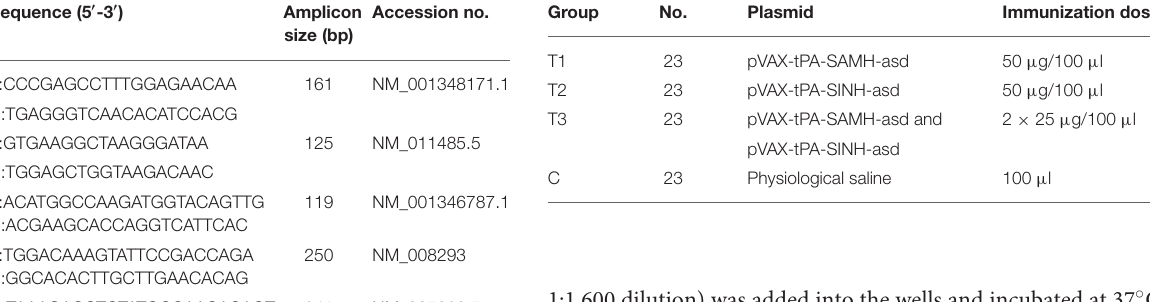
TABLE 1 | Primers for qRT-PCR in this study. Gene